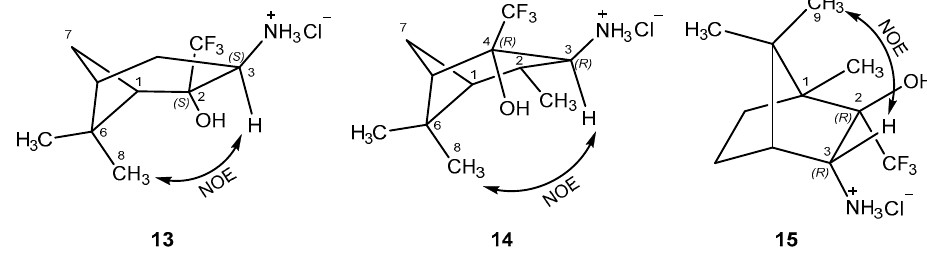
Figure 2. Structure and NOE interactions of compounds (2 S ,3 S )- 13 , (3 R ,4 R )- 14 , (2 R ,3 R )- 15 .